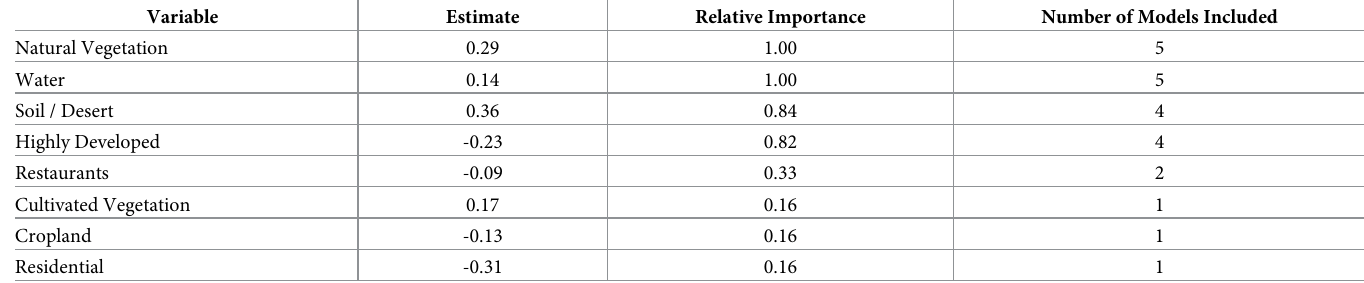
Table 4. Results from the model averaging (DAIC < 2) of the models investigating the relationship between community dissimilarity and variables of interest dur- ing the spring. Model averaged conditional beta estimates as well as relative importance and the number of top models the variable was included in. The variables are listed by relative